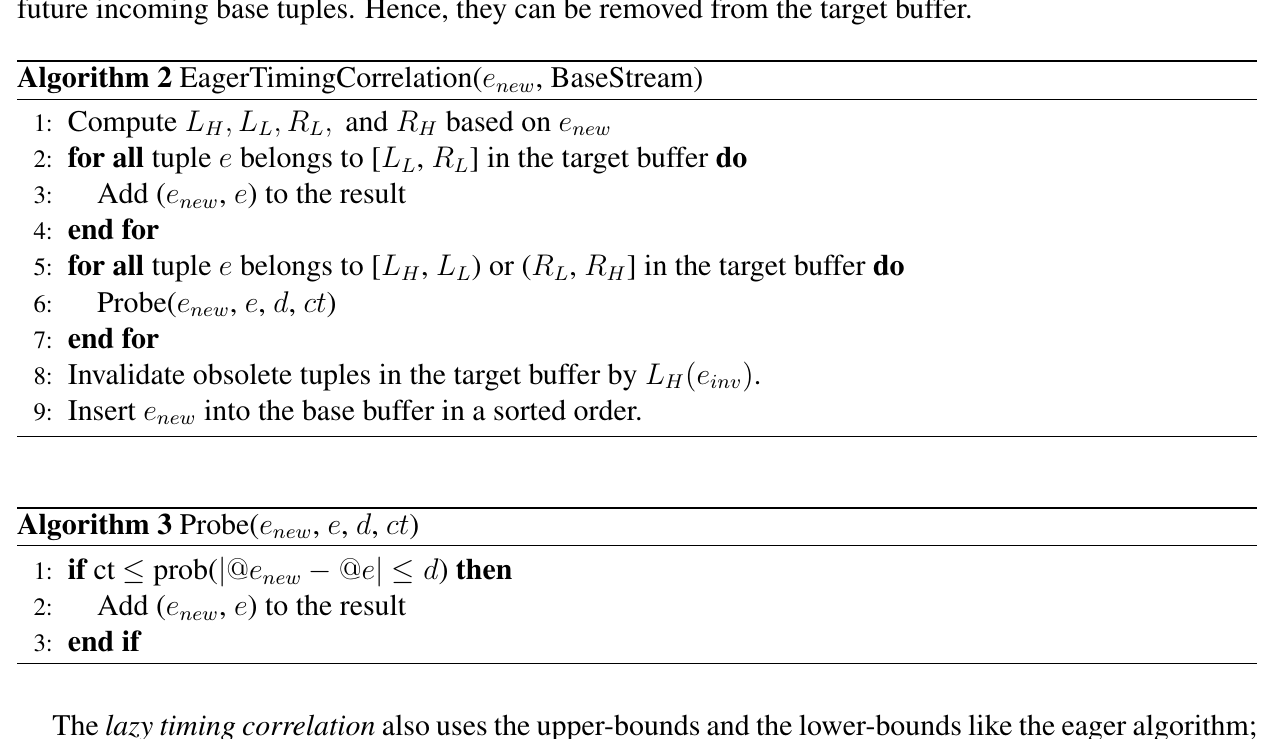
Algorithm 2 EagerTimingCorrelation( e